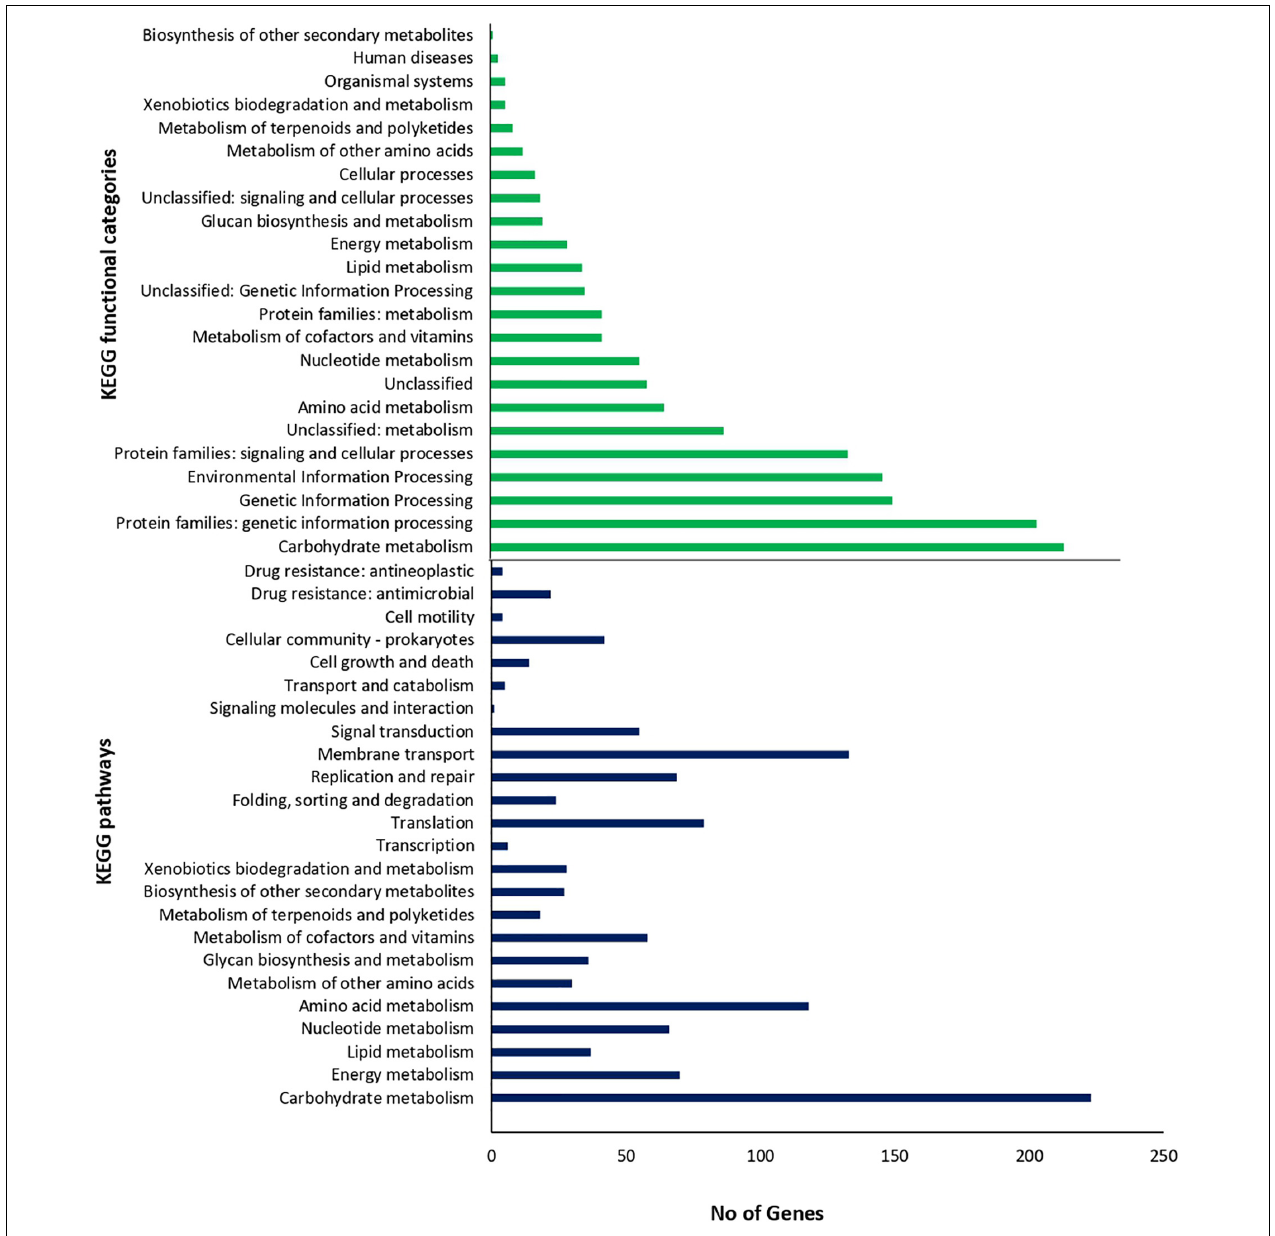
FIGURE 5 | Number of proteins assigned to KEGG functional categories and